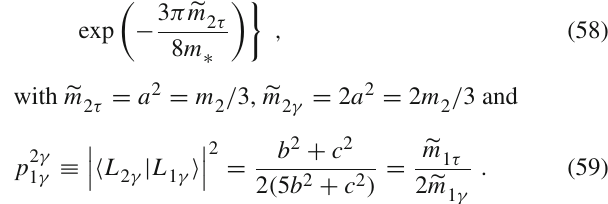
Fig. 8 In the TM2 μ - τ reflection symmetry scenario and the case of < M M , for some benchmark values of M 1 2 plotted lines), the values of ϑ versus the lightest neutrino mass for lep-